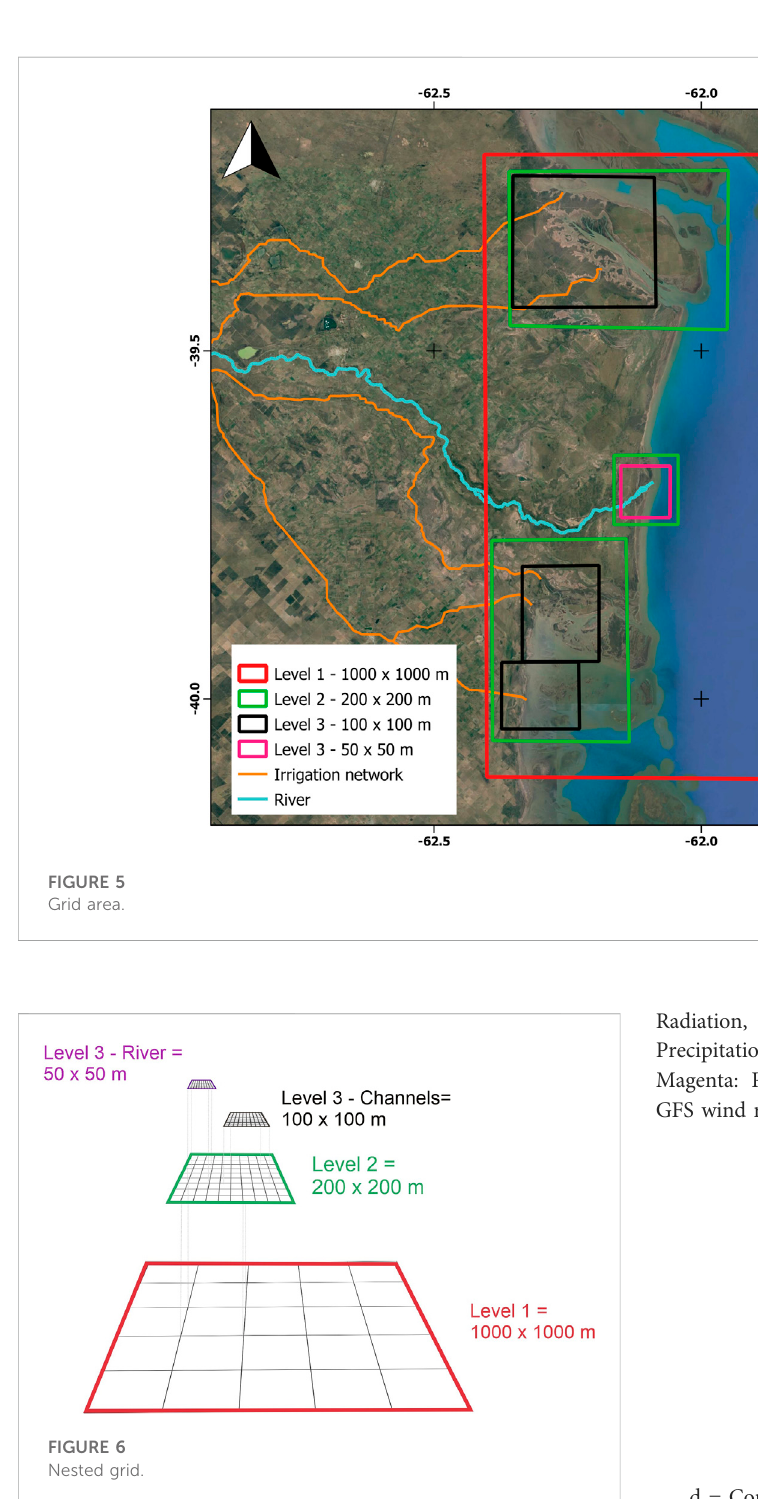
FIGURE 6 Nested